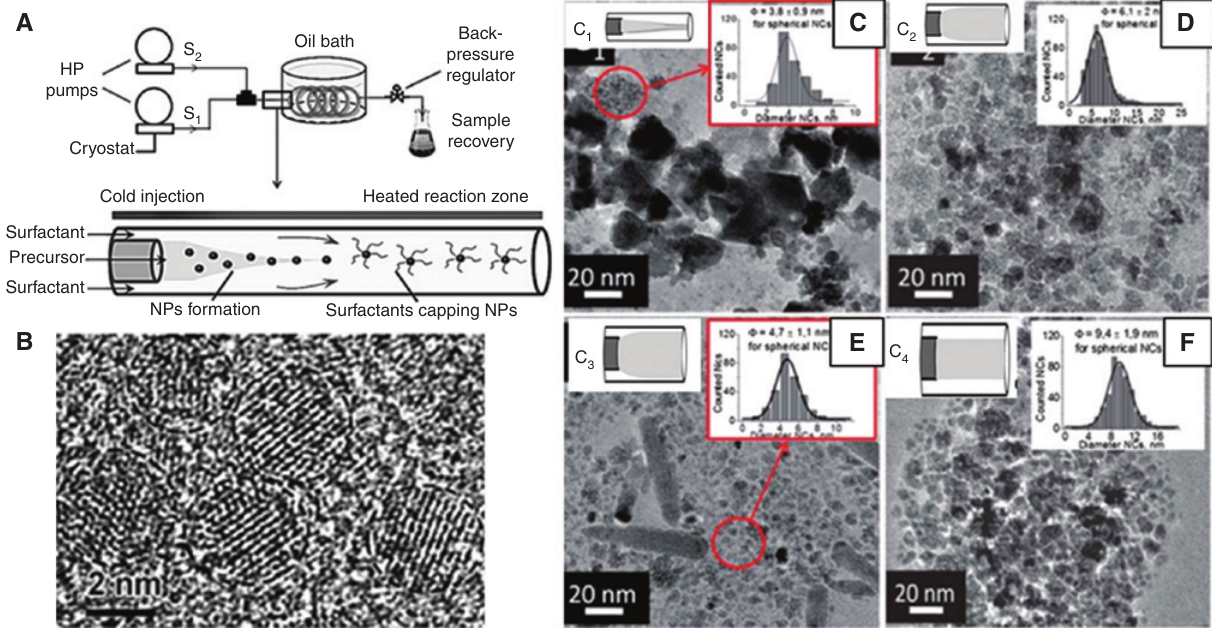
Figure 25: Micro- to milliscale co-flowing process for the synthesis of hybrid ZnO NCs. Reprinted with permission from Ilin ES, Marre S, Jubera V, Aymonier C, J. Mater. Chem. C 2013, 1, 5058–5063 [40], Copyright 2013 Royal Society of Chemistry, and from Roig Y, Marre S, Cardinal T, Aymonier C, Angew. Chem. Int. Ed. 2011, 50, 12071–12074 [106], Copyright 2011